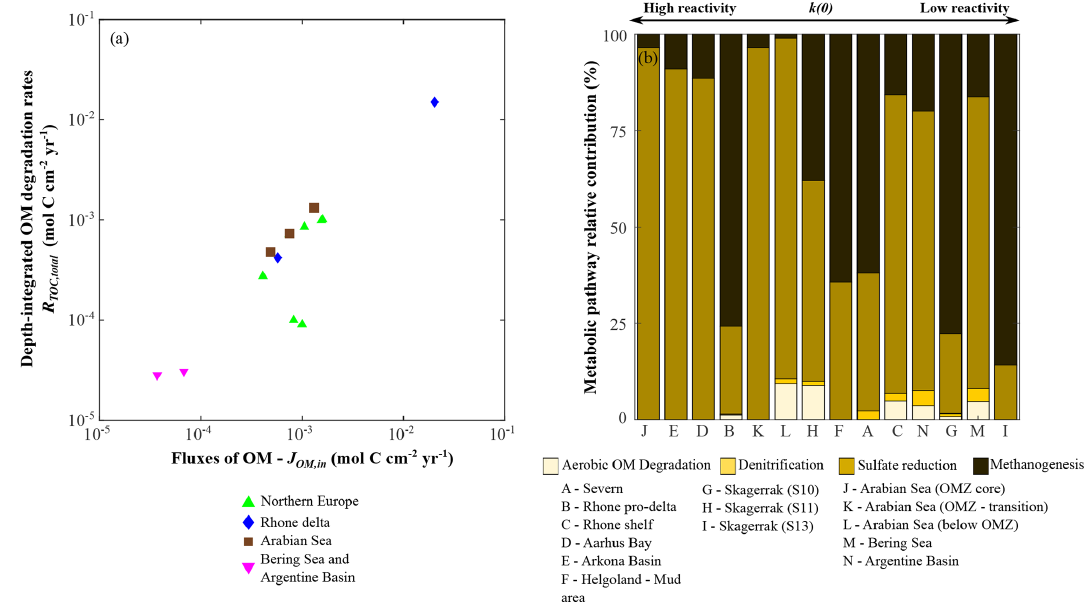
Figure 7. Benthic organic matter degradation dynamics. (a) Organic matter fluxes vs. depth-integrated organic matter degradation rates; (b) relative contribution of each metabolic pathway to heterotrophic organic matter